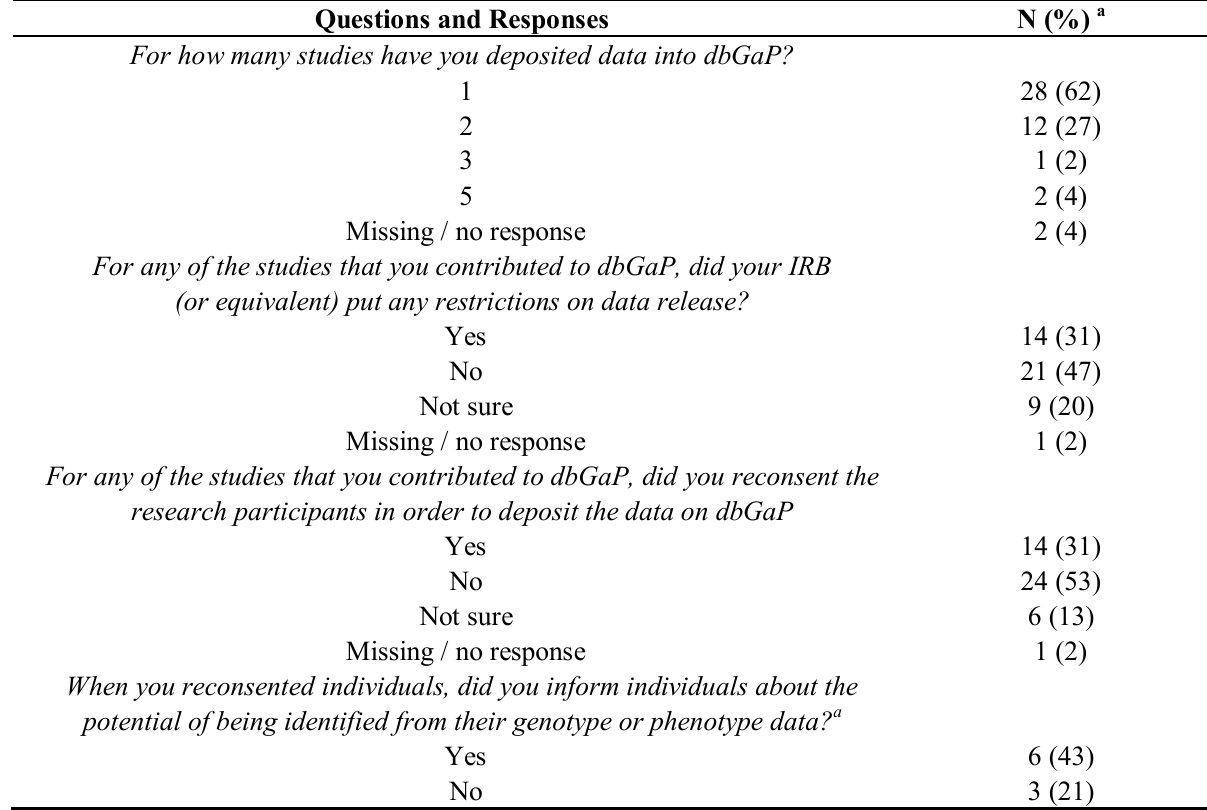
Table 5. Information about depositing data to dbGaP from 45